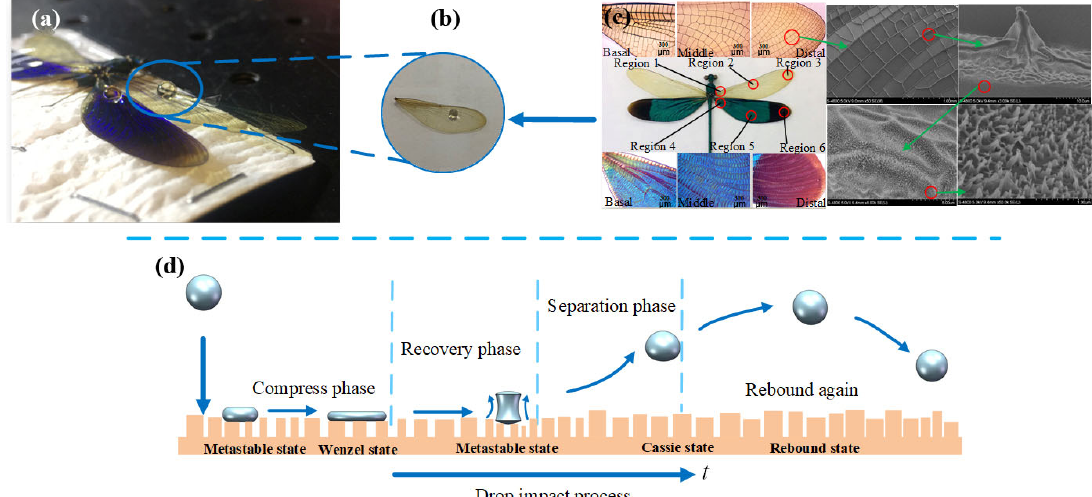
Fig. 1 Microstructure of dragonfly wings and diagram showing droplet impact motion on dragonfly wings. (a) Droplets collapsed onto surface of dragonfly wings. (b) Details of liquid bead on surface of dragonfly wing. (c) Structure and micromorphology of various section of dragonfly wing. (d) Model depicting motion of droplet on surface of dragonfly wing during each stage of impact, and the corresponding state of motion at each stage.